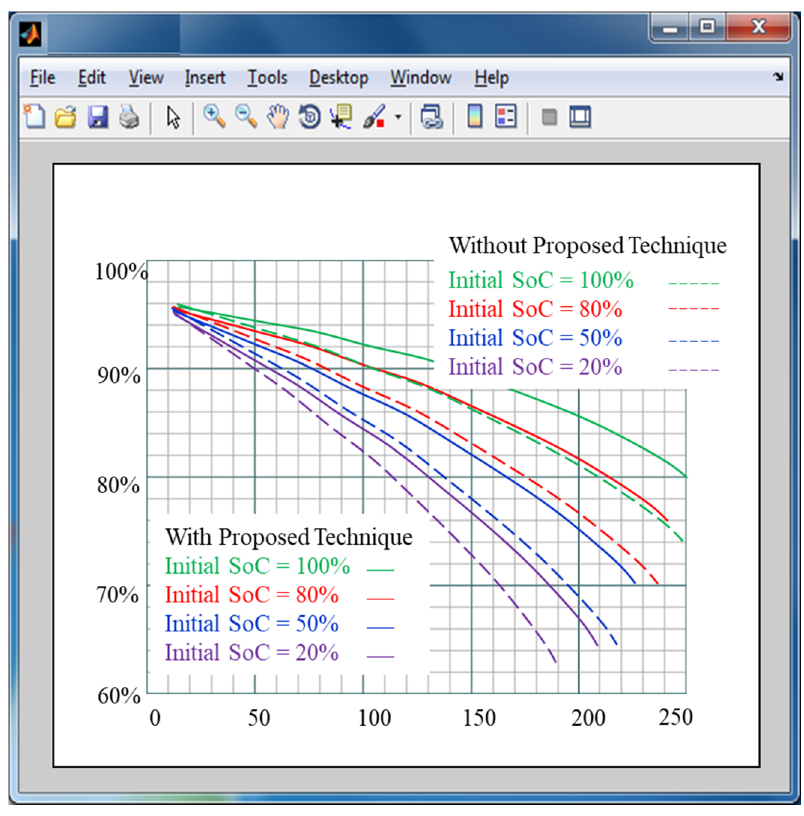
Figure 11. Discharge Efficiency Characteristics with and without Proposed Method.